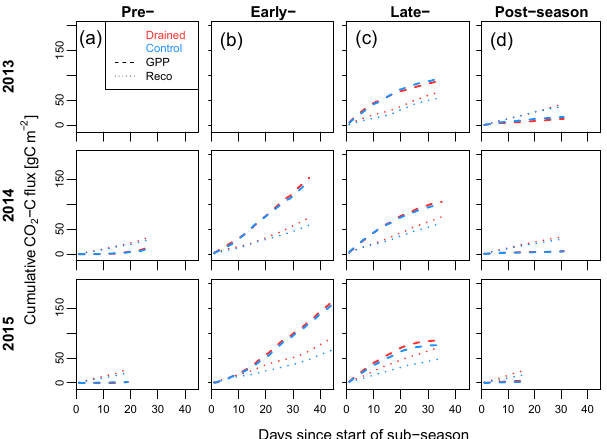
Days since start of sub−season